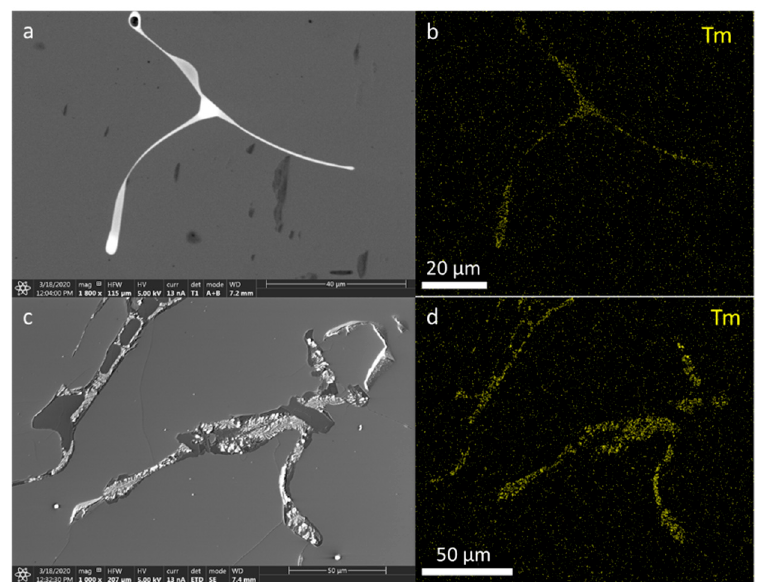
Figure 16. Sample presentation of the energy-dispersive spectroscopy analysis of the area from samples of LMP doped with 0.8-mol% Tb and 10-mol% B, with mapping of the Tm distribution (right-hand panels); top panels—sample No. 7, bottom panels—sample No. 22.